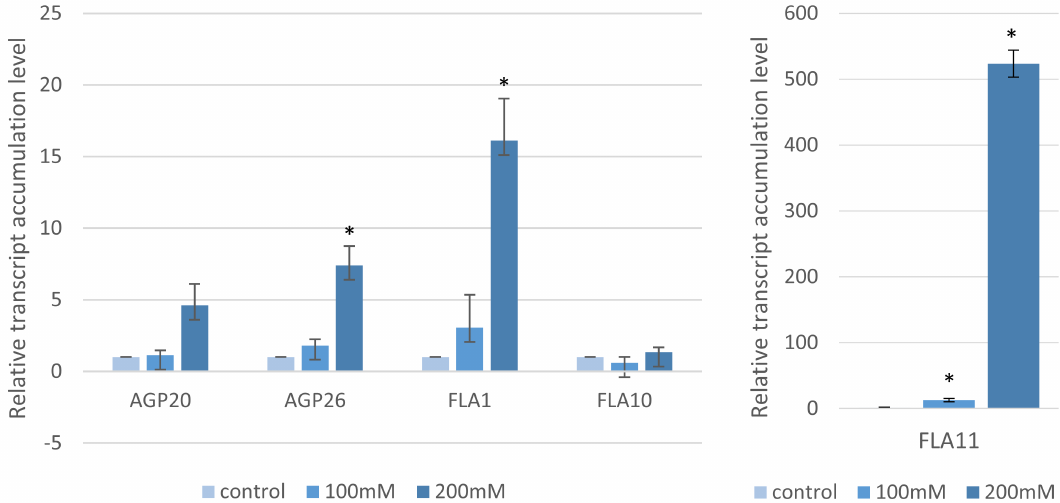
Figure 2. Relative level of the accumulation of the arabinogalactan proteins (AGP) and fasciclin–like AGP ( FLA ) gene transcripts after “salt stress” treatment with various concentrations of NaCl. The relative expression levels were normalized to an internal control (Bradi1g32860; encoding ubiquitin) and calibrated to the control. Asterisks indicate significant differences from the control using the Student’s t -test ( p < 0.05; mean ± SD, n = 3).